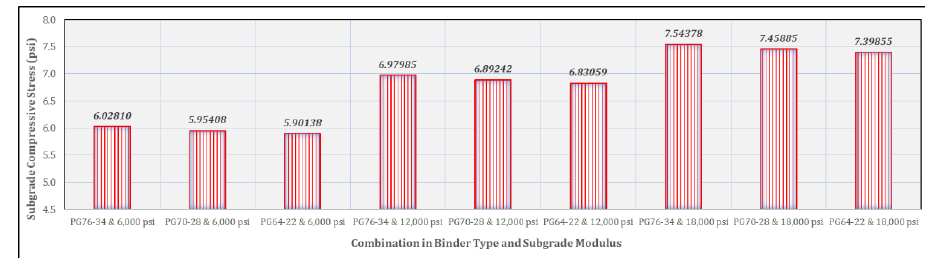
Figure 33: Influence of subgrade modulus and binder type on subgrade compressive stress in asphaltic overlayment rail track.